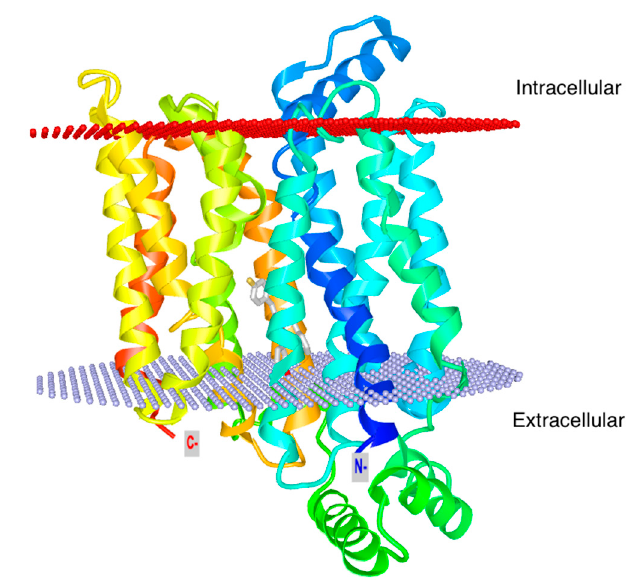
Figure 2. Glut1 structure. Ribbon model of GLUT1 in the ligand-bound inward facing conformation (PDB: 4PYP; https://www.rcsb.org/structure/4PYP). The N terminus is colored in blue and the C terminus in red. The corresponding transmembrane segments in the four 3-helix repeats are colored the same. The position of glucose bound in the inward facing state is depicted in gray sticks. The structure figure is customized with iCn3D.